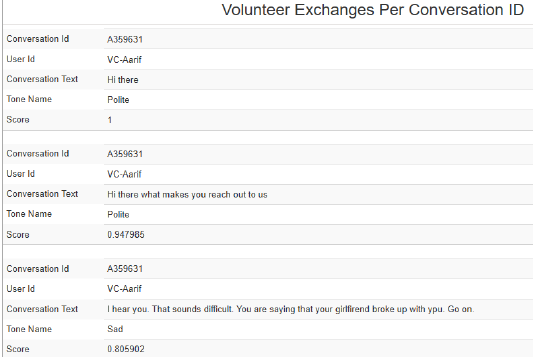
Figure 22. Average –Tone Analysis (Per